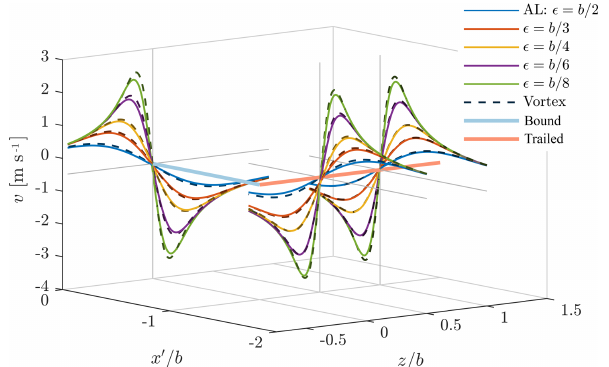
Figure 6. Velocities induced perpendicular to a rectangular wing predicted by an actuator line (AL) without correction and by vor- tex segments with a viscous core (Vortex) with different smearing parameters. Velocities are shown along lines cutting the bound and trailed vortices at right angles and y = 0. Only half of the horseshoe vortex is depicted as x (cid:48) = x − ( b + r v = 1